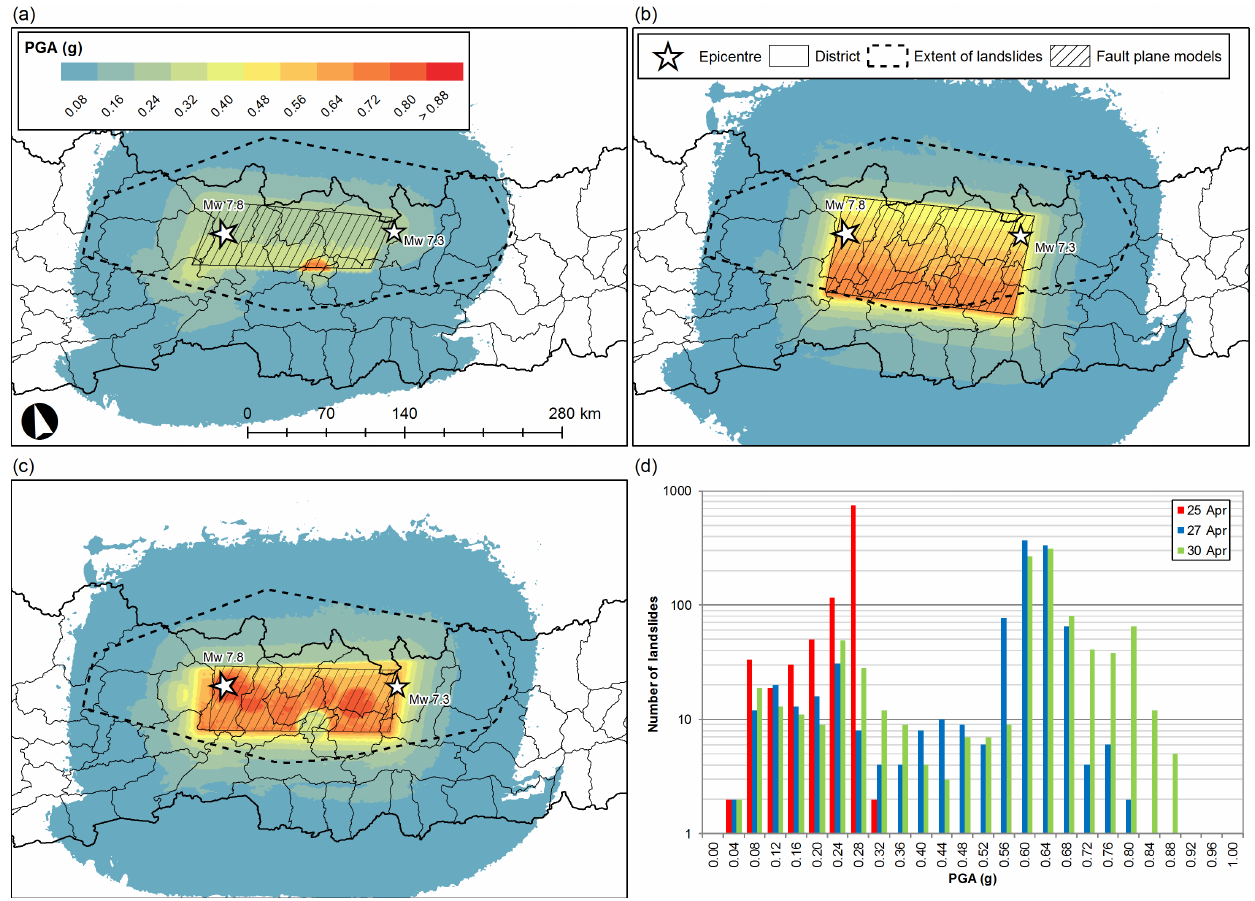
Figure 4. Changes in modelled peak ground acceleration and fault plane following the 2015 Gorkha earthquake. (a) 25 April 2015 (0 days after earthquake); (b) 27 April 2015 (2 days after earthquake); (c) 30 April 2015 (5 days after earthquake); and (d) frequency distribution of training landslides ( n = 2006) for each PGA model. Data from USGS